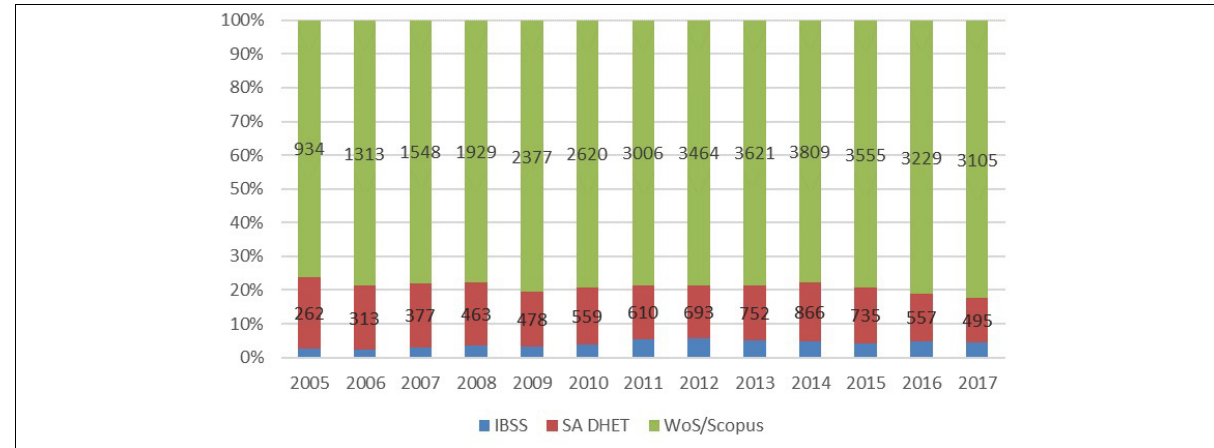
Figure 5: Articles disaggregated by journal